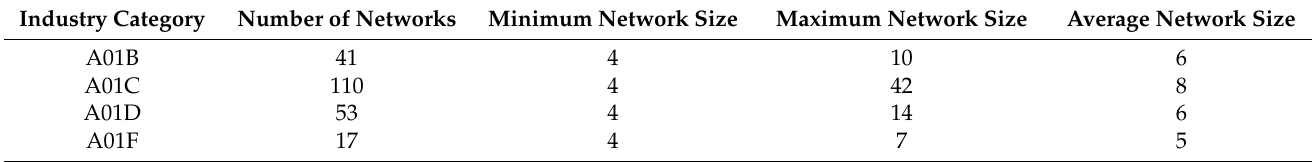
Table 1. Network Number and Node Distribution of Each